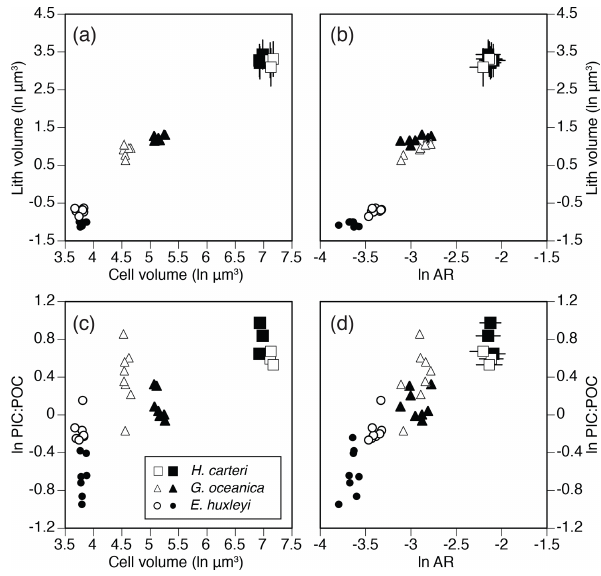
Figure 6. Cross-plots of physiological and coccolith morphol- ogy parameters as measured in different strains of three modern coccolithophore species. (a) Cell volume (lnµm 3 ) vs. coccolith vol- ume (lnµm 3 ). (b) Coccolith volume vs. aspect ratio (natural loga- rithmic scale). (c) Cell volume vs. PIC:POC ratio (natural logarith- mic scale). (d) Coccolith aspect ratio vs. PIC:POC ratio. Error bars in (a) , (b) and (d) represent ± 1SD of coccolith measurements in replicate cultures. Data sources: Šupraha et al. (2015; H. carteri ) and McClelland et al. (2016; G. oceanica and E. huxleyi